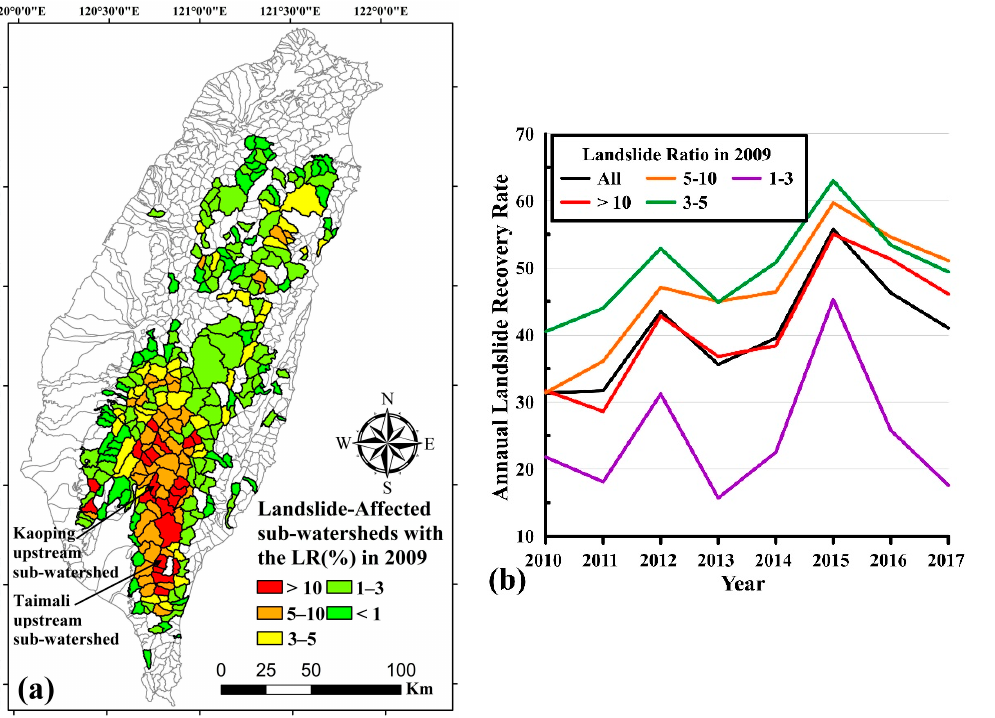
Figure 9. Distribution ( a ) and the annual landslide recovery rate ( b ) of 278 landslide-affected sub- watersheds after the 2009 Typhoon Morakot in Taiwan.